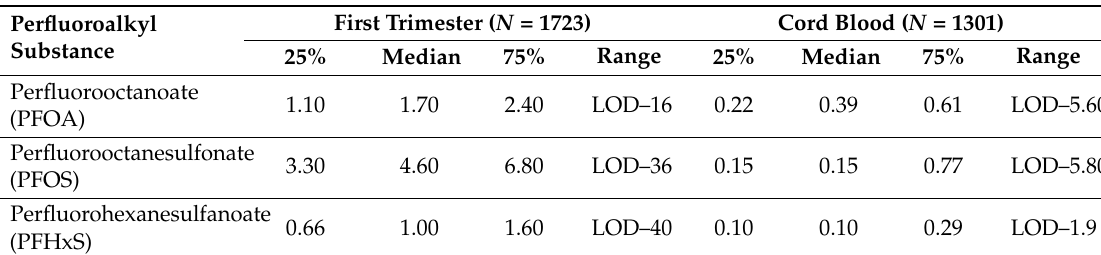
Table 2. Descriptive statistics of first trimester maternal and cord blood plasma perfluoroalkyl substance levels (ng/mL) a .